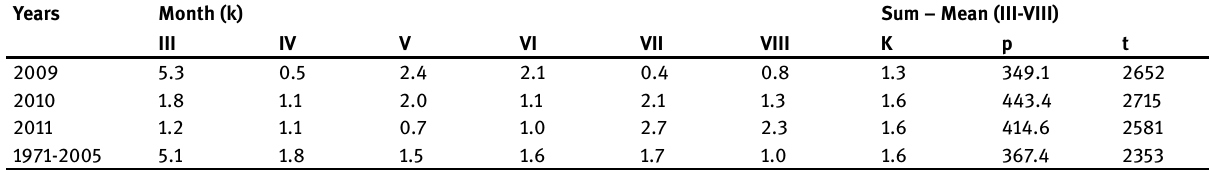
Table 1: Sums of rainfall (mm) and mean air temperature (°C) in 2009-2011 and long-term averages from 1971-2005 (Zamość Research Station). Years Month